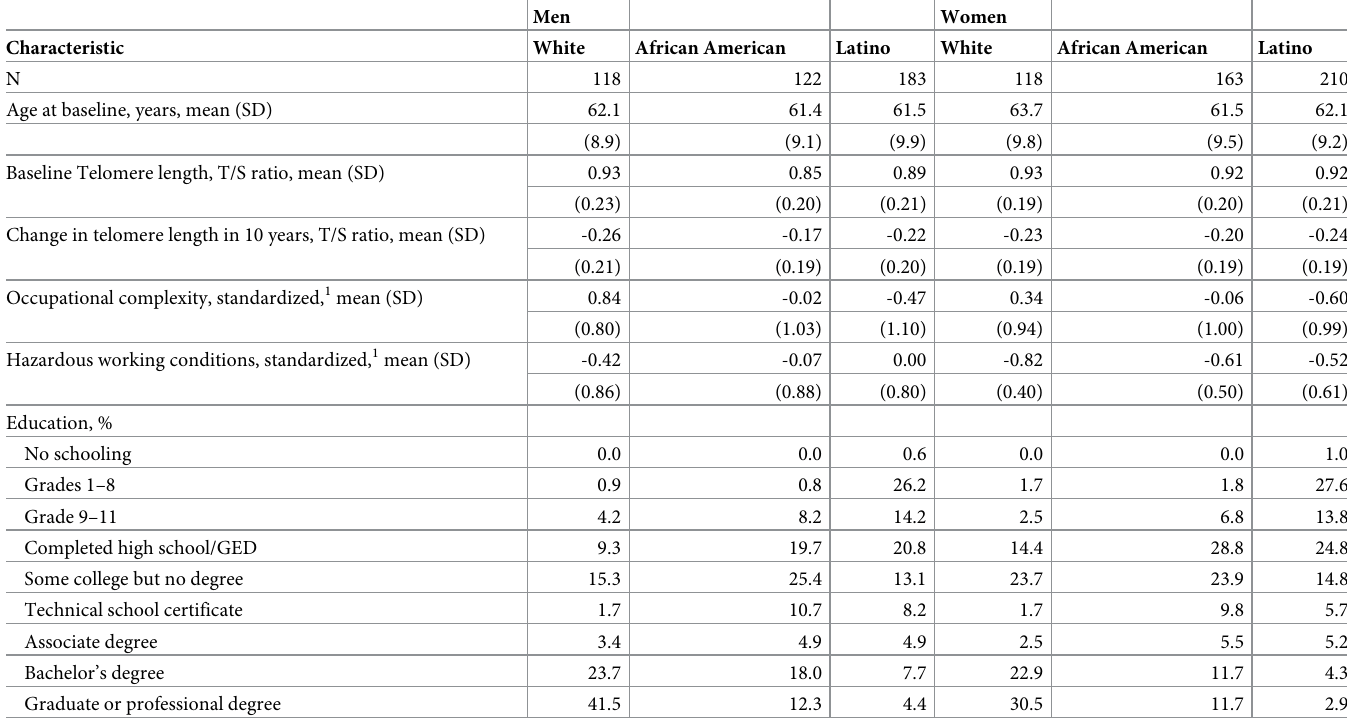
Table 1. Demographic characteristics, baseline TL, and change in TL over 10 years. Men